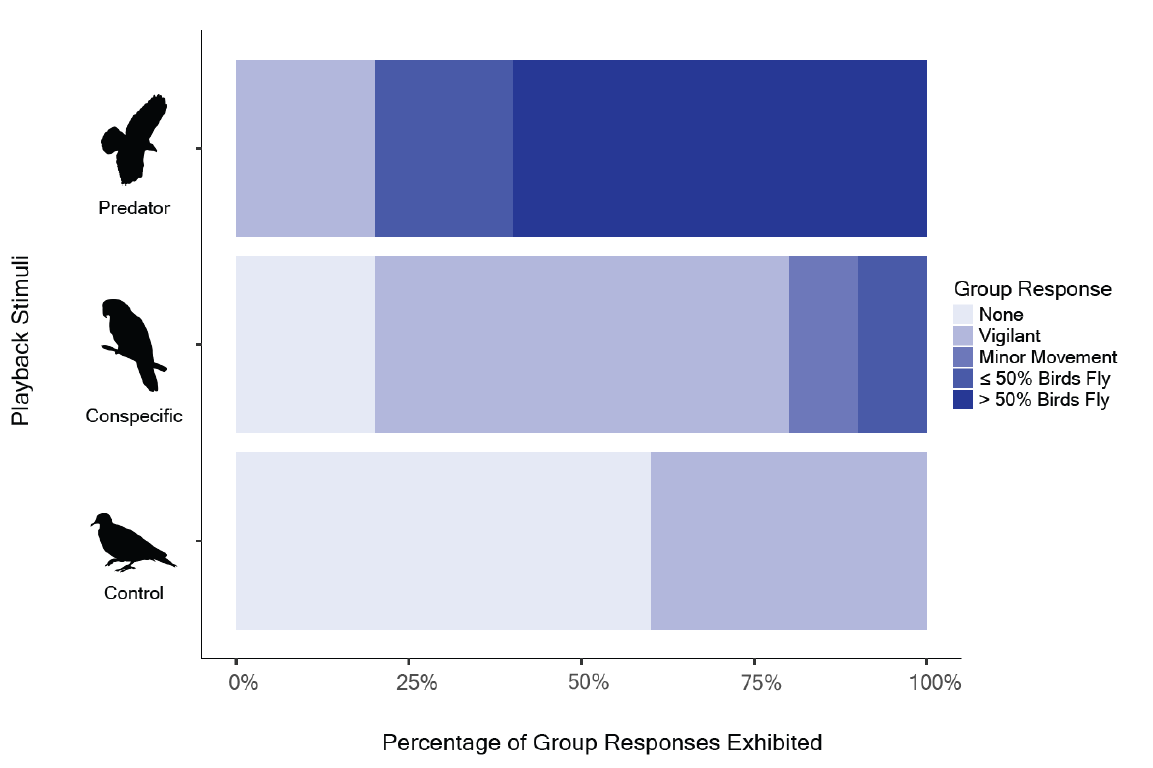
The Percentage of Monk Parakeet Group Responses in Response to Playback